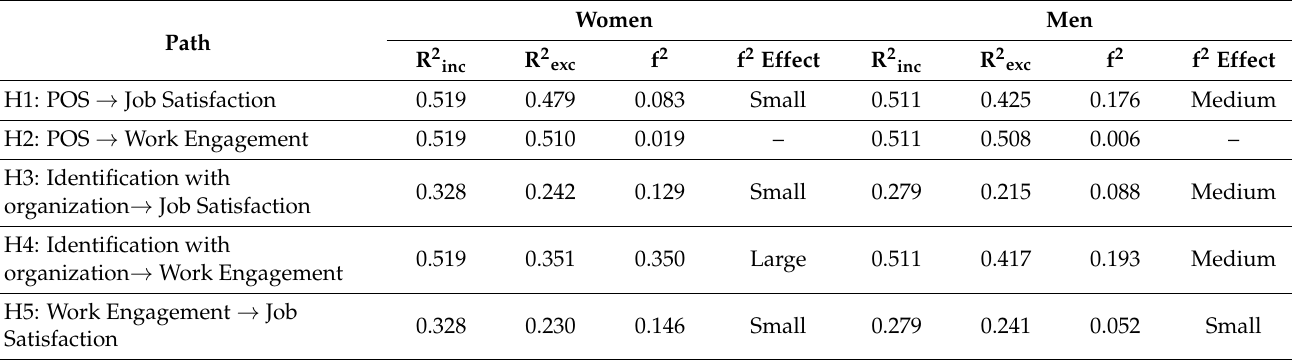
Table 6. R 2 and f 2 of proposed model’s constructs in relation to